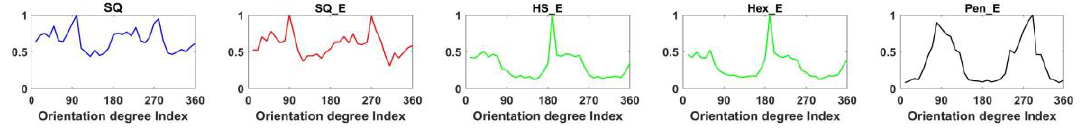
Figure 15. The ANCHORs of different types of images when the pixel size is increased by 20% and gap factor is 0%. Table 2. The average MSE of orientation of four image types with pixel size increase of 20% and 0% gap factor. Referred to 0% Gap Factor Gap factor SQ_E HS_E Hex_E Pen_E 0% 0.0039 0.0036